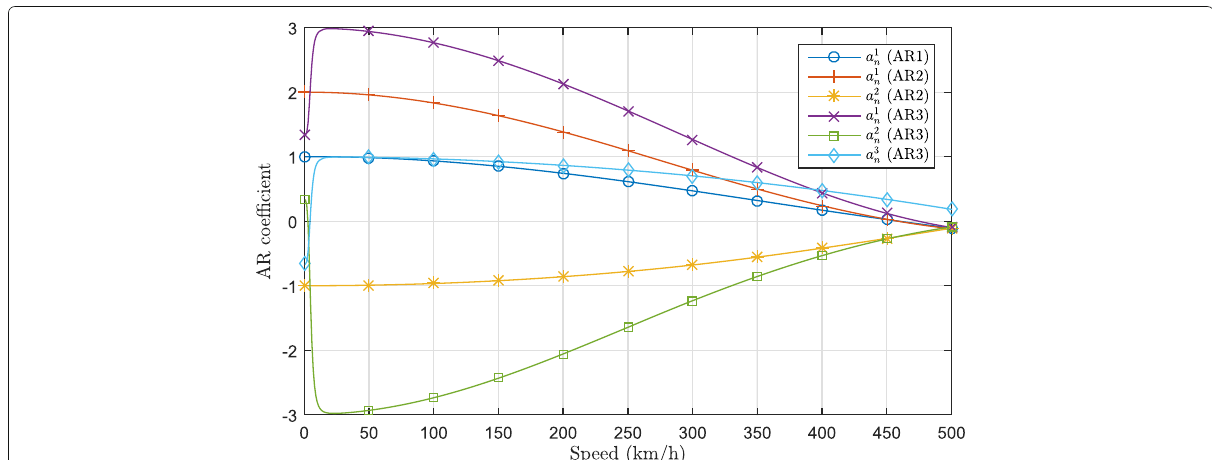
Fig. 9 AR model coefficients, found by solving (7), as a function of the speed of the UE